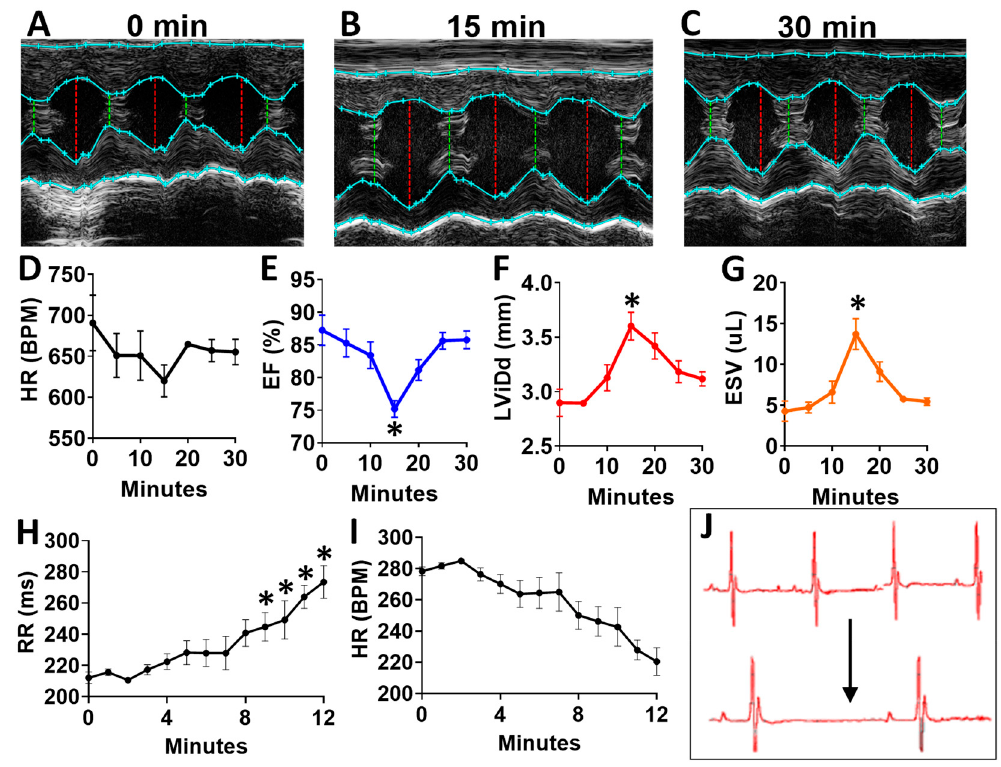
Figure 7. N-[2-[[(Hexahydro-2-oxo-1H-azepin-3-yl)amino]carbonyl]phenyl]benzo[b]thiophene-2- carboxamide (ANA12) injection leads to acutely altered ventricular function and bradycardia in wild-type animals ( A ) Example M-mode echocardiographic traces at baseline ( A ) and at 15 min ( B ) and 30 min ( C ) after a single injection of ANA-12. Plot showing results of echocardiography assessment in mice ( n = 4) at baseline and at 5 min intervals, including the following echocardiographic parameters (y axis) ( D ) heart rate, ( E ) percent (%) ejection fraction (EF) and ( F ) end systolic volume (ESV) and left ventricular internal dimension at G, diastole (LVID;d); n = 4. Asterisks represent statistical significance. For EF (* p = 0.0183, n = 4), LVID; d (* p = 0.0169, n = 4), and ESV (* p = 0.0190, n = 4). Plots showing the RR interval ( H ) and heart rate (HR, I ) as measured by electrocardiography in ANA-12 injected wild-type mice ( n = 4). Example electrocardiograms are also shown ( J ) at baseline (top) and at 12 min after ANA-12 treatment (bottom). Asterisks represents statistical significance (* p < 0.01, n = 4). Colors are for emphasis as follows: blue = EF%, red = LViDd, orange =